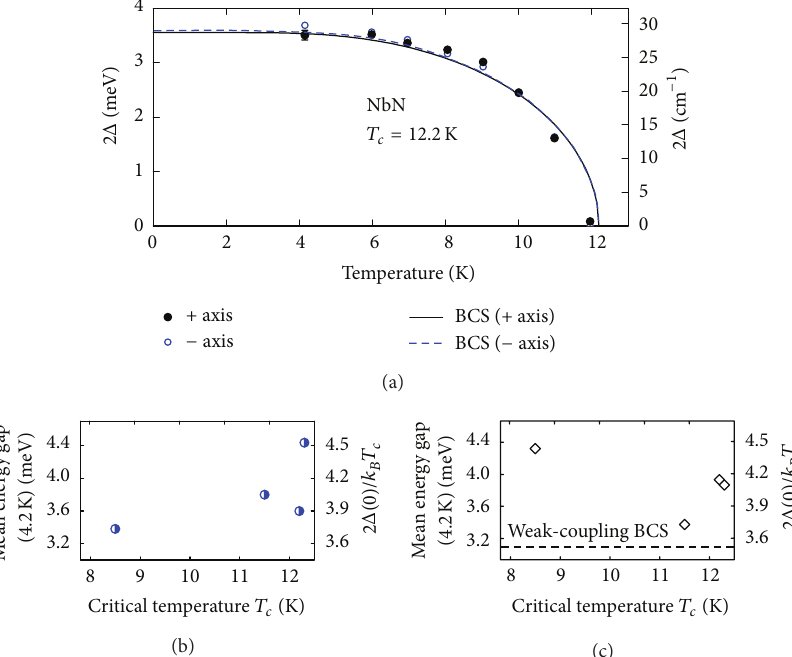
Figure 17: (a) Energy gap 2Δ versus temperature of a NbN sample for both main axes of the substrate. Solid lines are the fits according to BCS theory. Results on both main axes yield very similar values of 2Δ(𝑇) . The error bar shown is representative for all data. (b) 2Δ at 4.2 K and (c) ratios 2Δ(0)/𝑘 𝐵 𝑇 𝑐 versus 𝑇 𝑐 of several NbN films deposited with different parameters, yielding different transition temperatures (after